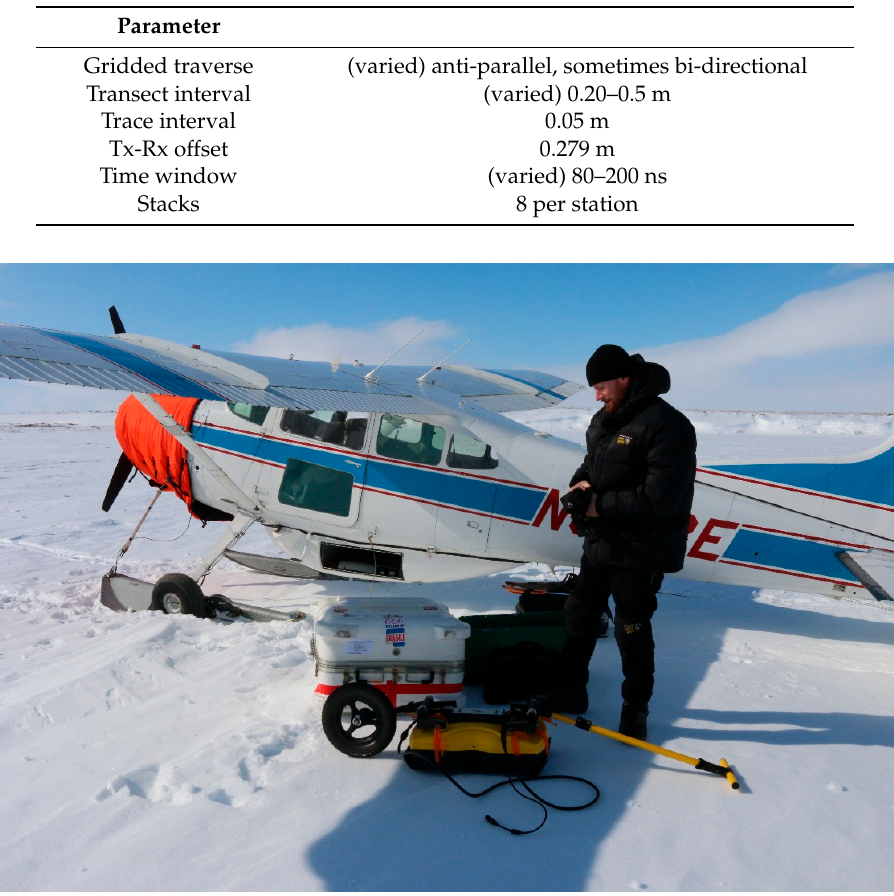
Figure 3. Fieldwork landing site at Bering Land Bridge. Shown: T. Urban. Photo by J. Rasic.